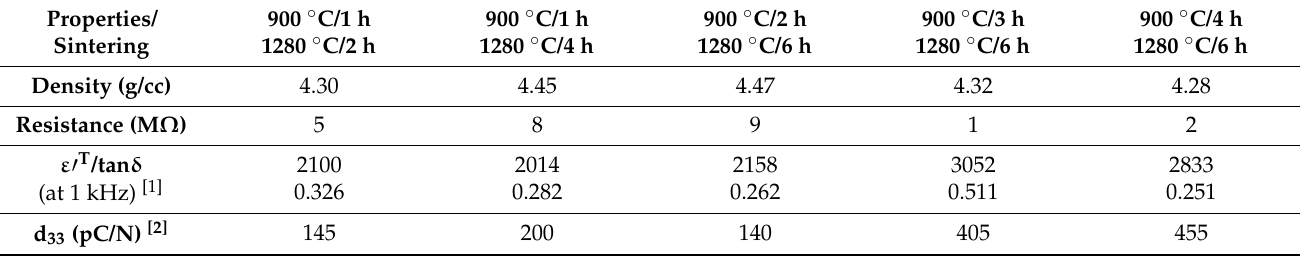
Table 3. Some properties of the sintered ceramics after synthesis at 700 ◦ C for 2 h under variable time and temperature using a two-step sintering method.